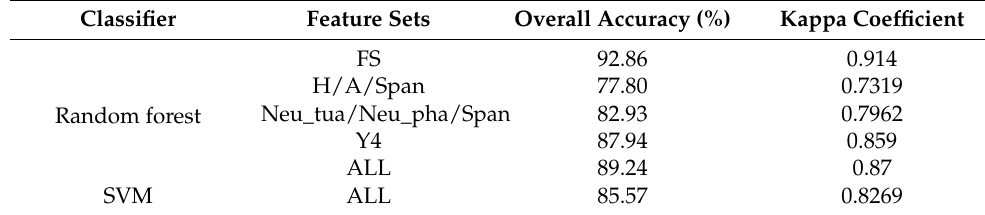
Table 3. Accuracy of the different feature sets.